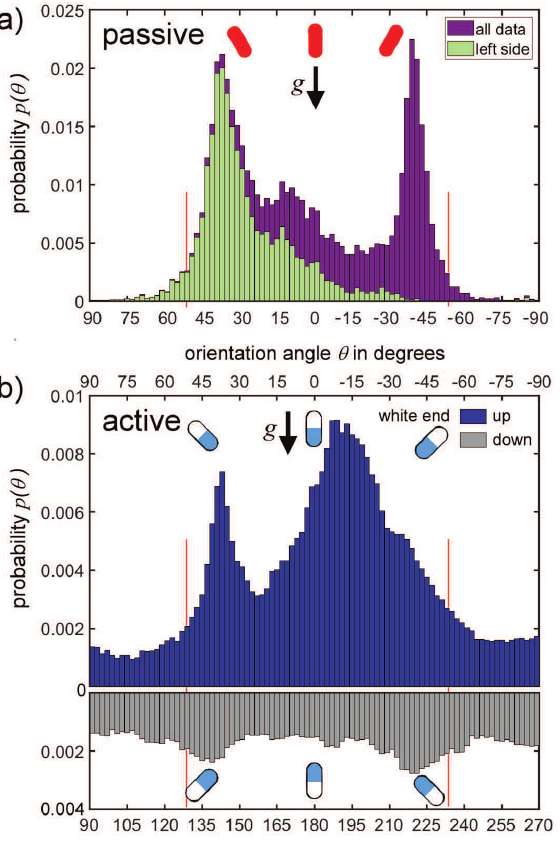
Figure 5. Orientations of capsules in a distance of ≤ 1 capsule length above the outlet during discharge, red lines mark the orientation of the compartment borders, 0 ◦ refers to the long axes perpendicular to the outlet (paral- lel to the direction of gravity), for active particles white head down: (a) passive capsules, probability distribution function of all data (purple) and of capsules lying left of the middle of the outlet (green). (b) active capsules, up- per panel: head up, lower panel: head down. Normaliza- tion taken over all data. Excitation a = 1 . 6 g , opening d = 21 mm , tilt 2 . 5 ◦